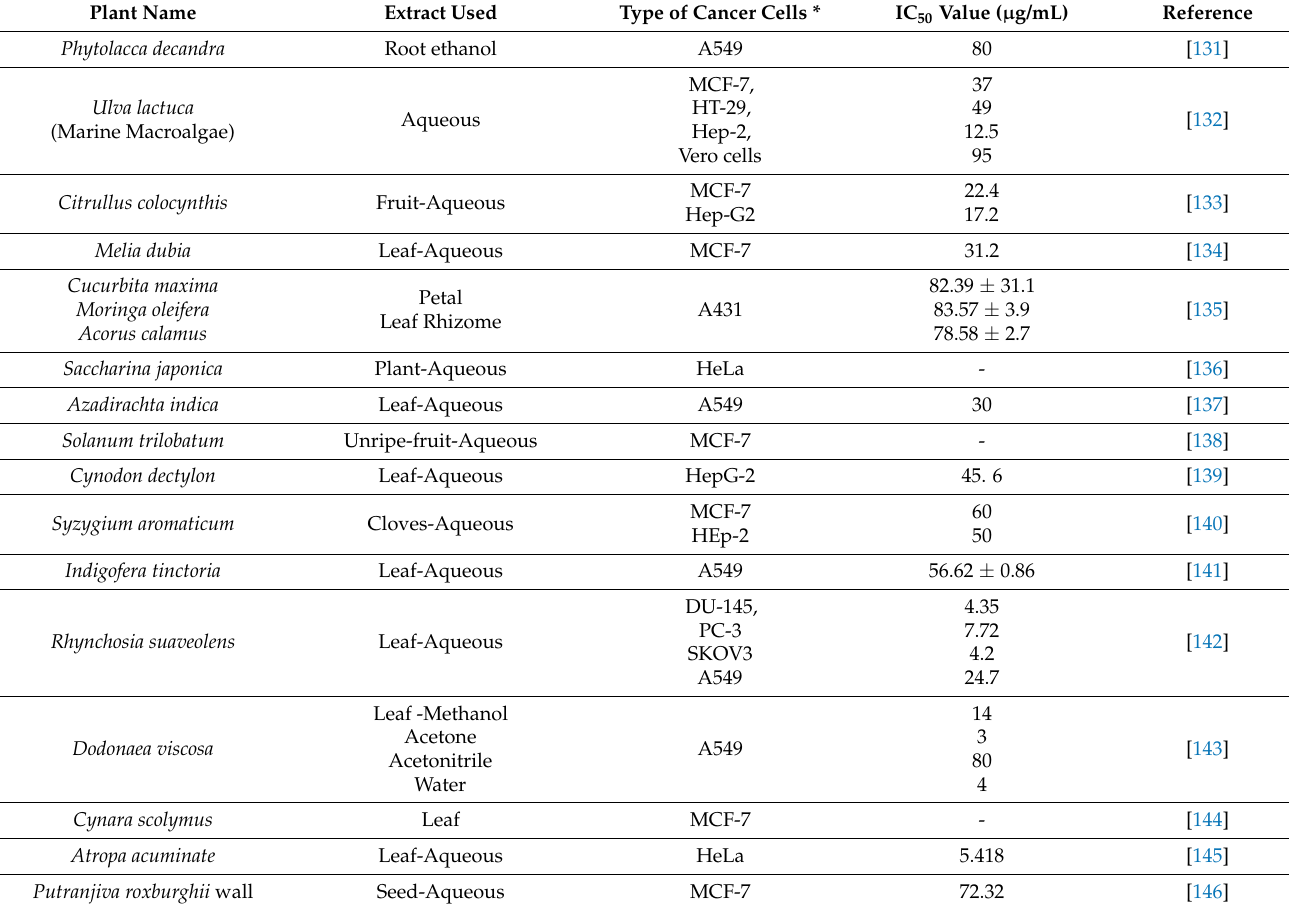
Human gastric cancer cells.